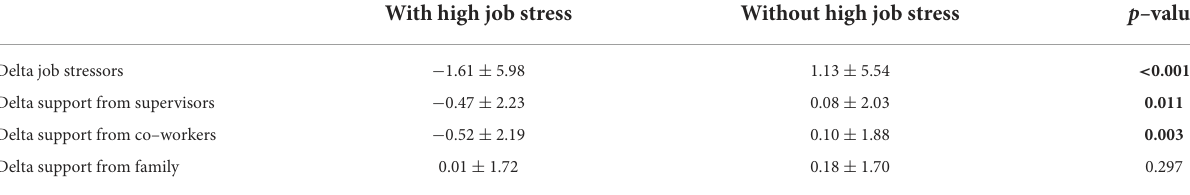
TABLE 5 Changes in job stressors and social supports according to high job stress.